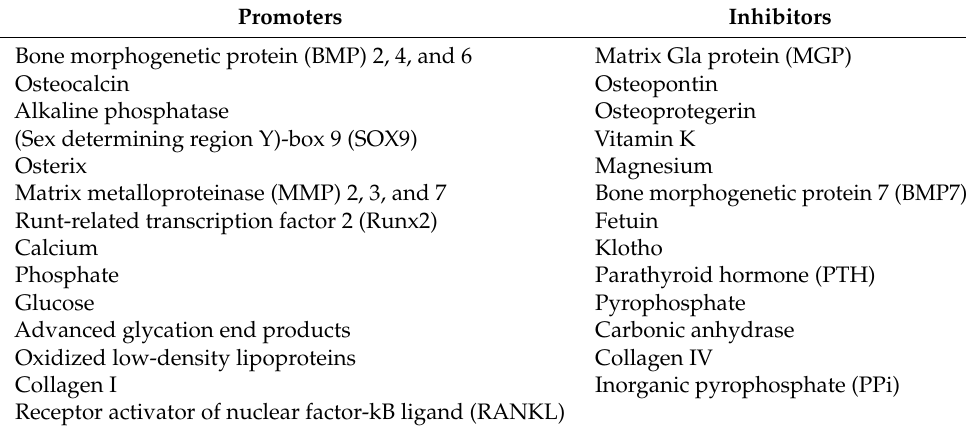
Table 1. Major promoter and inhibitor factors involved in vascular